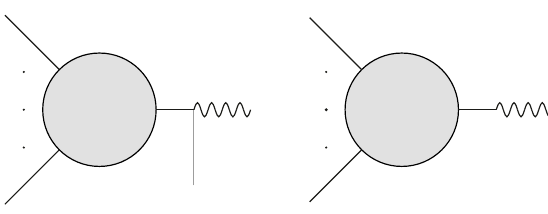
Figure 8 . Removing the soft scalar from the gluon-scalar-scalar vertex. The gray line stands for the soft